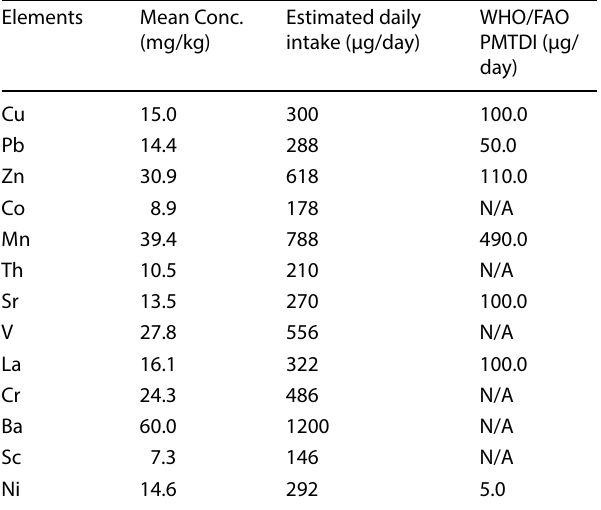
Table 4 Comparison of estimated probable daily intake (PDI) with WHO/FAO standard [29]